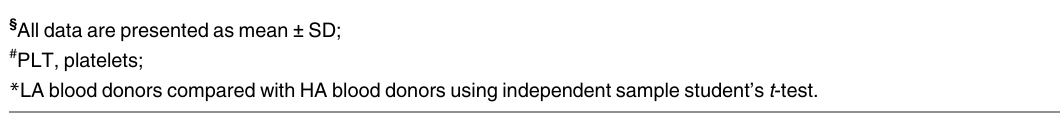
The results of total plasma protein content and basic coagulation tests (PT, aPTT, and TT)